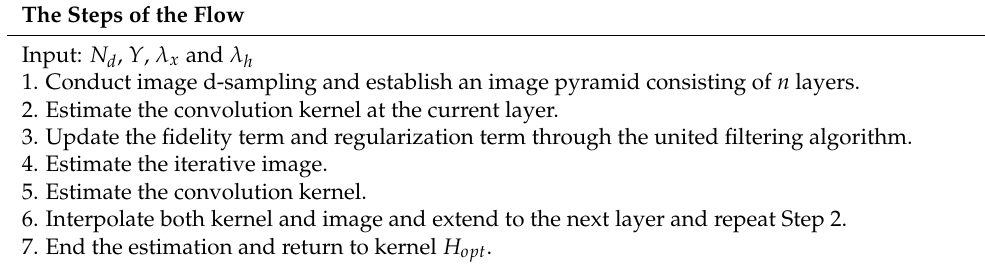
Table 1. Iterative estimation algorithm flow of kernel